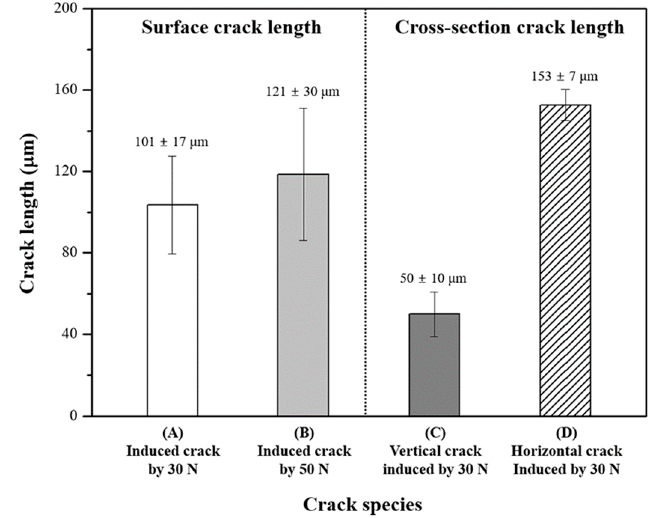
Figure 3. Crack lengths measured on the surface and cross-sectional images before cyclic thermal fatigue (CTF) tests.